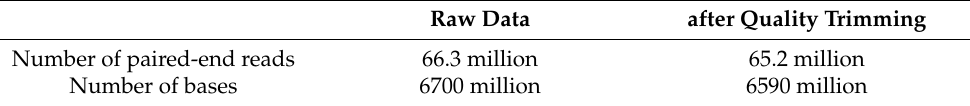
Table 1. Sequencing statistics.